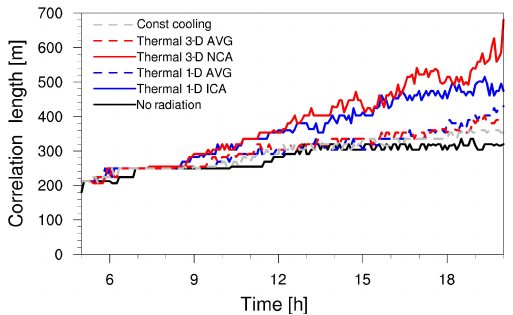
Figure 14. Time development of correlation length. The correlation length is defined by the shift where the correlation coefficient drops below 1 /e